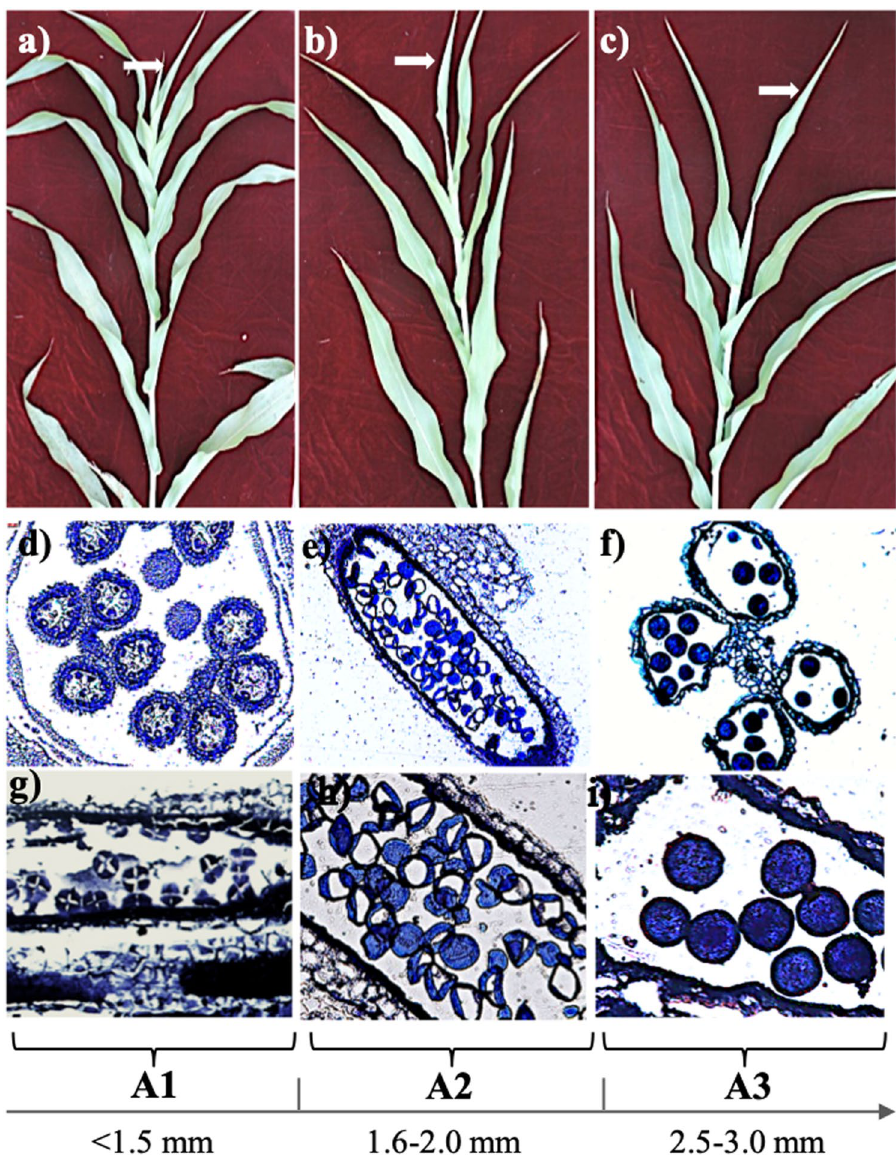
Figure 1. Staging of sorghum anthers. The position of flag leaf, shown by a white arrow, varying from partial to complete emergence in ( a ) A1, ( b ) A2, and ( c ) A3 stages was used as indicator of stage of development. Sections of florets representing A1 ( d , g ), A2 ( e , h ) and A3 ( f , i ) stages at 100 × and 400 × magnification,